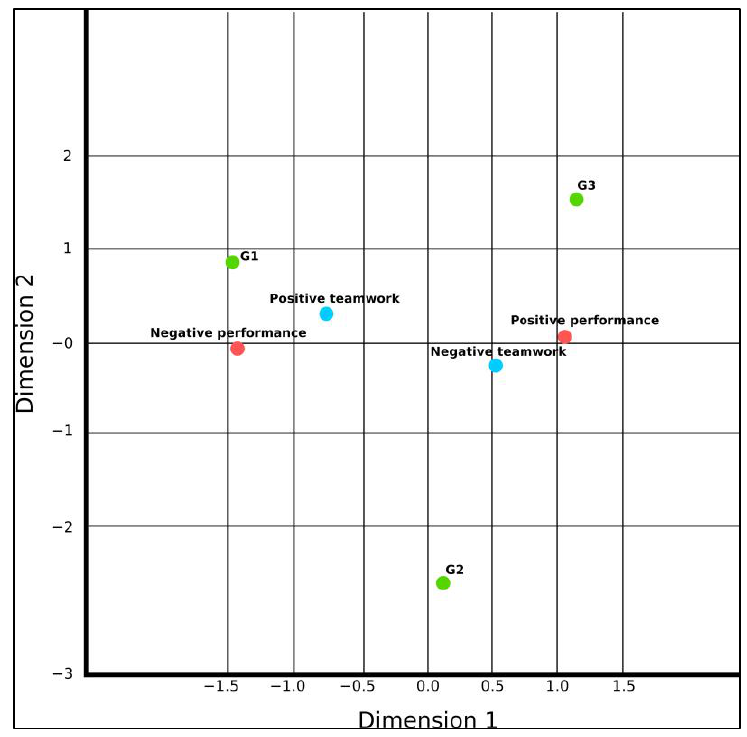
Figure 3. Correspondence between symptomatic groups, team workload, and performance.